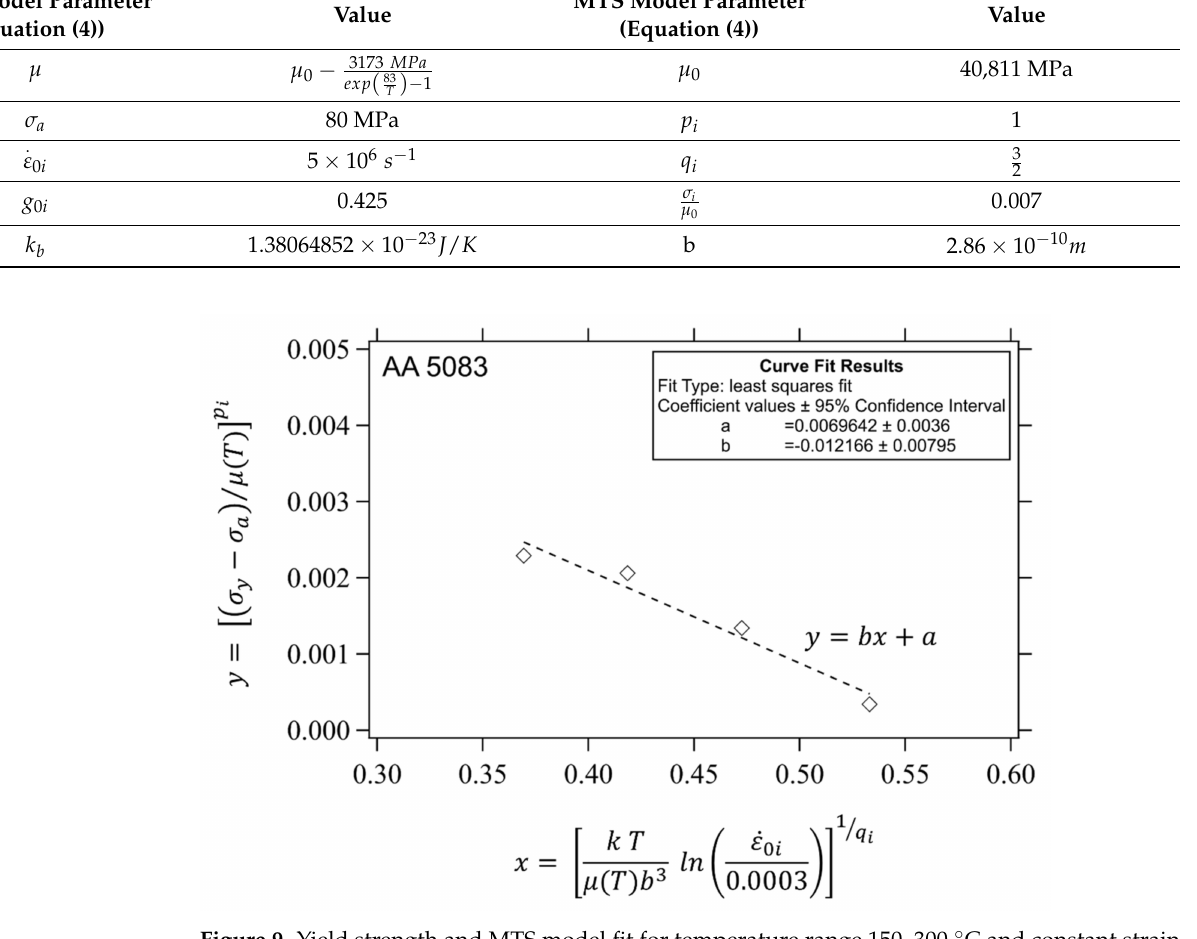
Figure 9. Yield strength and MTS model fit for temperature range 150–300 ◦ C and constant strain rate of 3 × 10 − 4 s − 1 . Model parameters are given in Table 2.